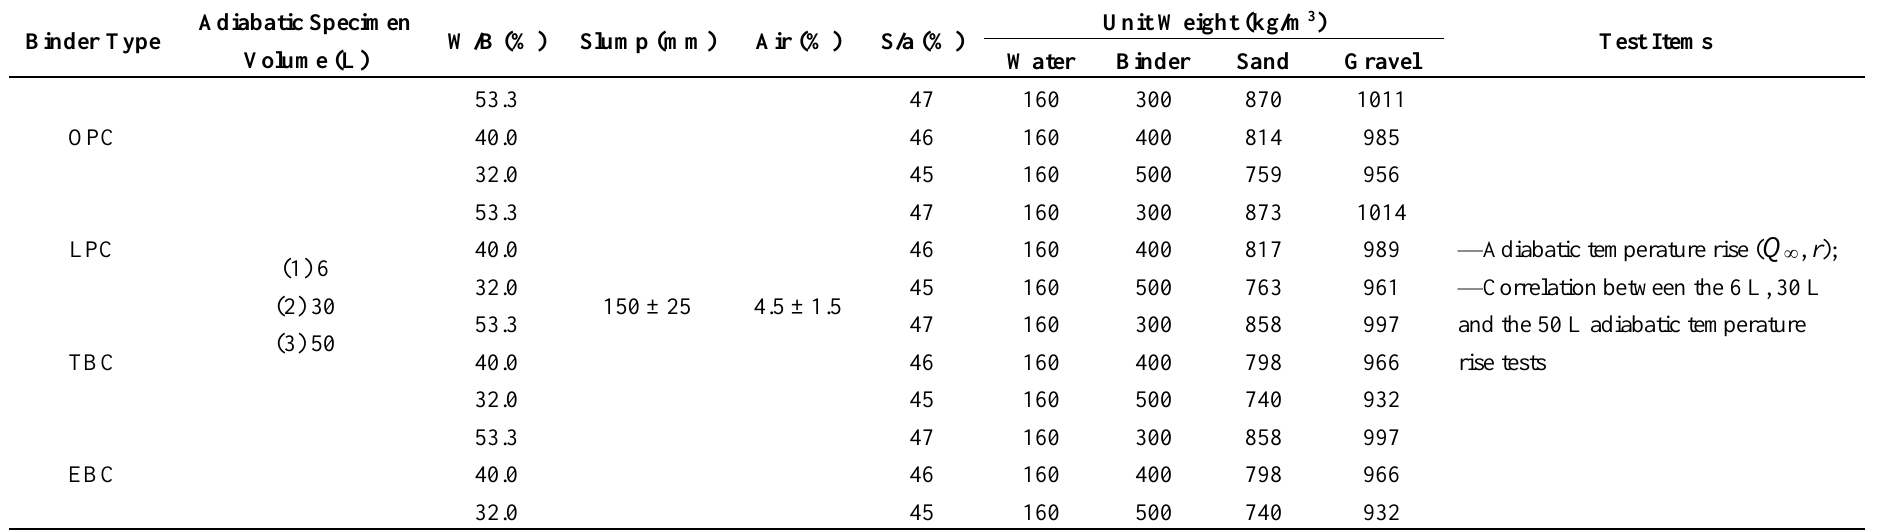
Table 1. Experimental plan and mix proportion.